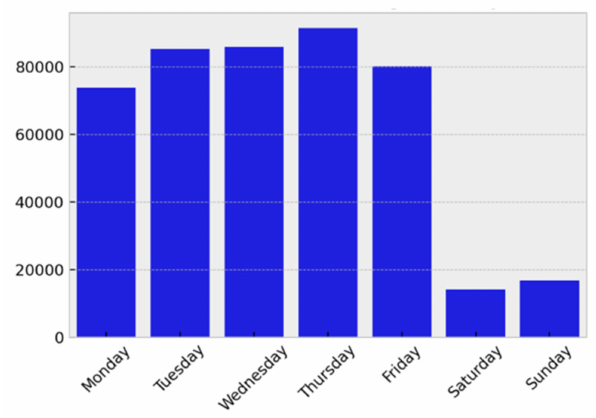
Figure 3. Amount of Bloomberg news by